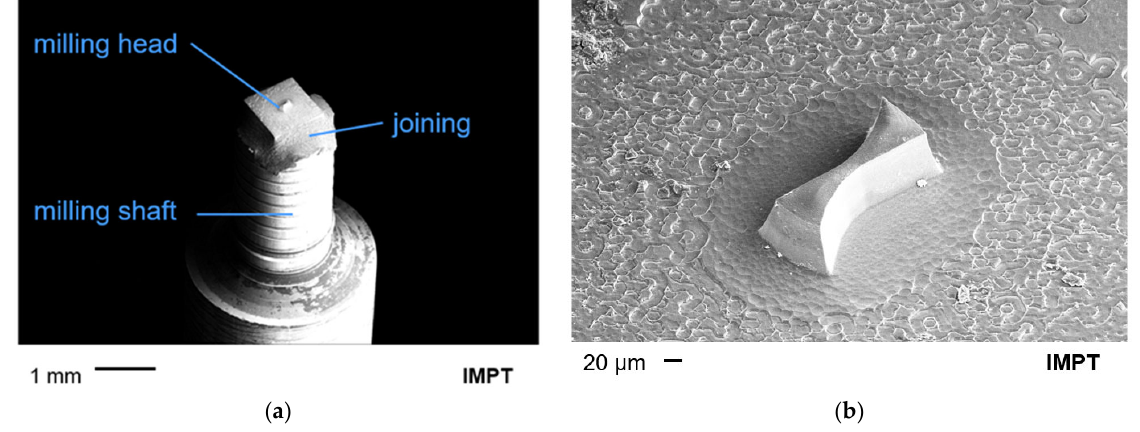
Figure 8. SEM image of ( a ) finalized milling tool with a diameter of 160 μ m and ( b ) a detailed view.